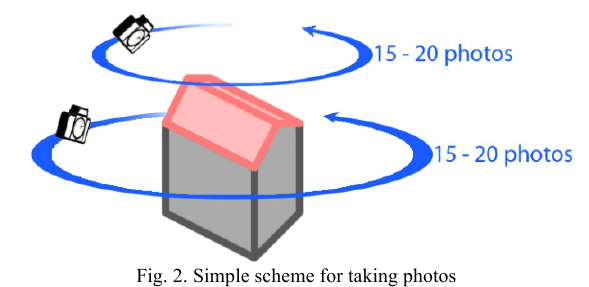
Fig. 2. Simple scheme for taking photos